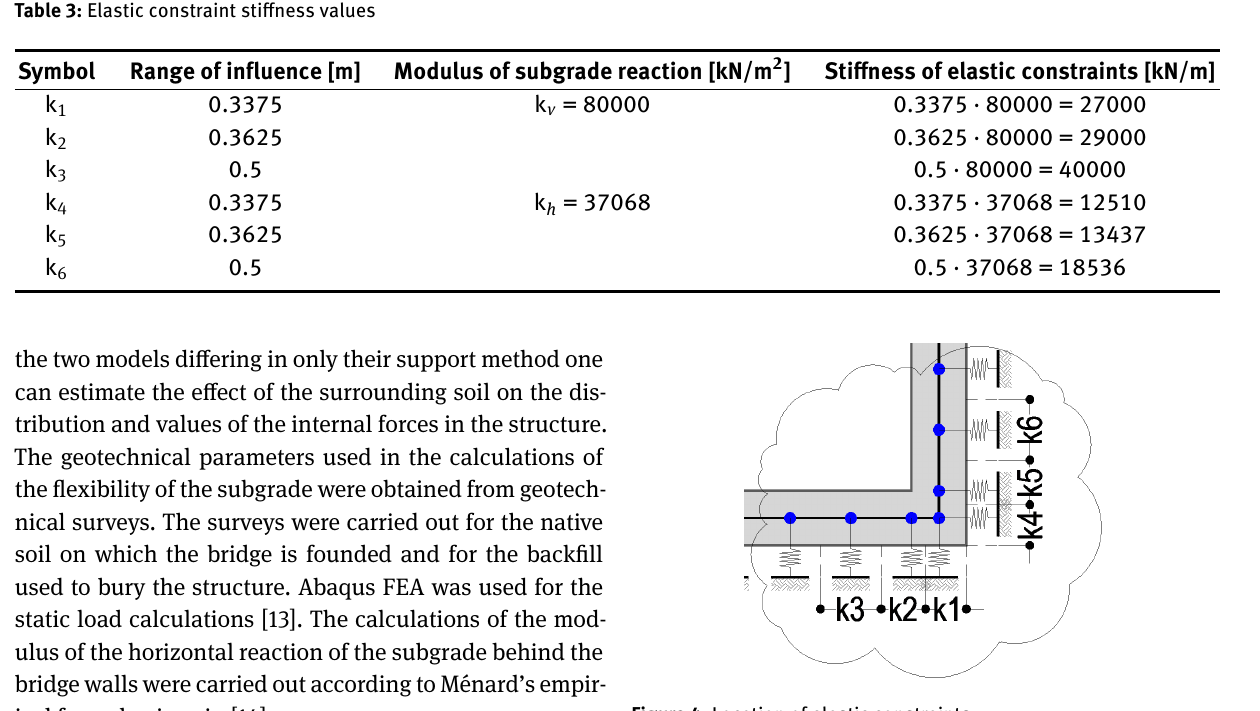
Table 3: Elastic constraint stiffness values